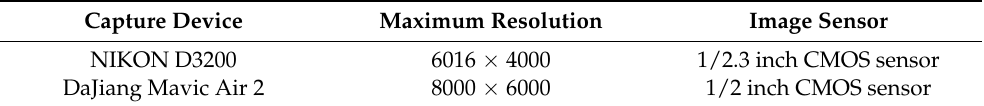
Table 1. Capture device information.